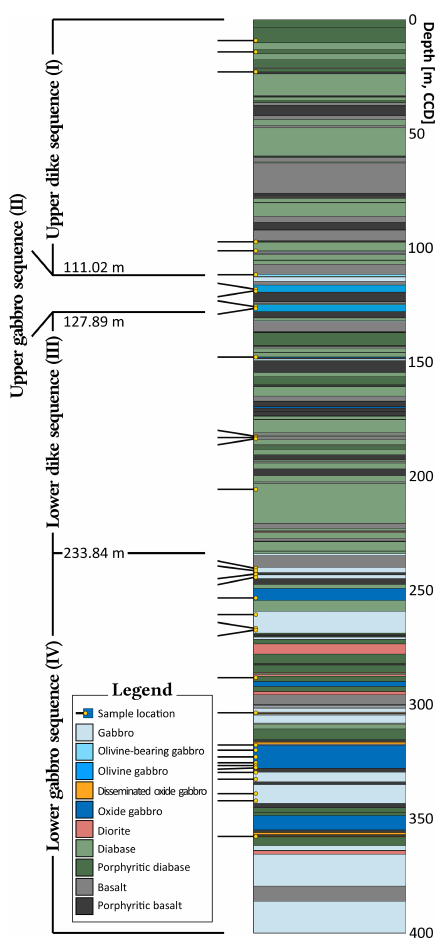
Figure 3. Units and sub-units as defined by Kelemen et al. (2020). The positions of the 36 investigated samples are